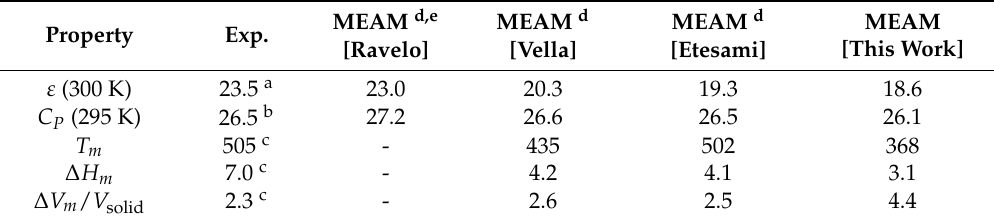
Table 4. Calculated thermal properties of pure Sn using the present 2NN MEAM potential, in comparison with experimental data and the calculation results using previous MEAM potentials by Ravelo and Baskes [5], Vella et al. [12], and Etesami et al. [13]. The listed quantities correspond to the thermal expansion coefficient ε (10 − 6 /K), the heat capacity at constant pressure C P (J/mol K), the melting temperature T m (K), the enthalpy of melting ∆ H m (kJ/mol), and the volume change upon melting ∆ V m / V solid